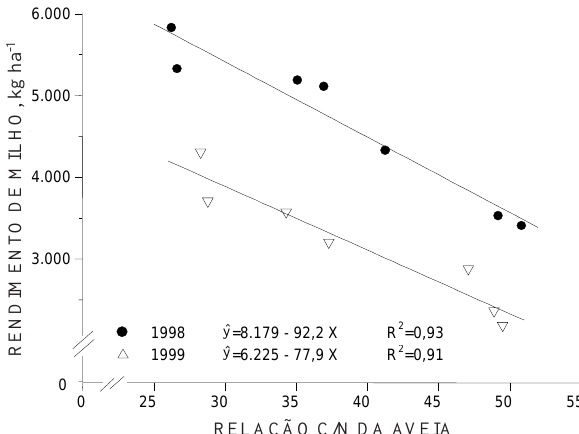
Figura 8. Rendimento de grãos de milho de acordo com a relação C/N da aveia nos anos de 1998 e